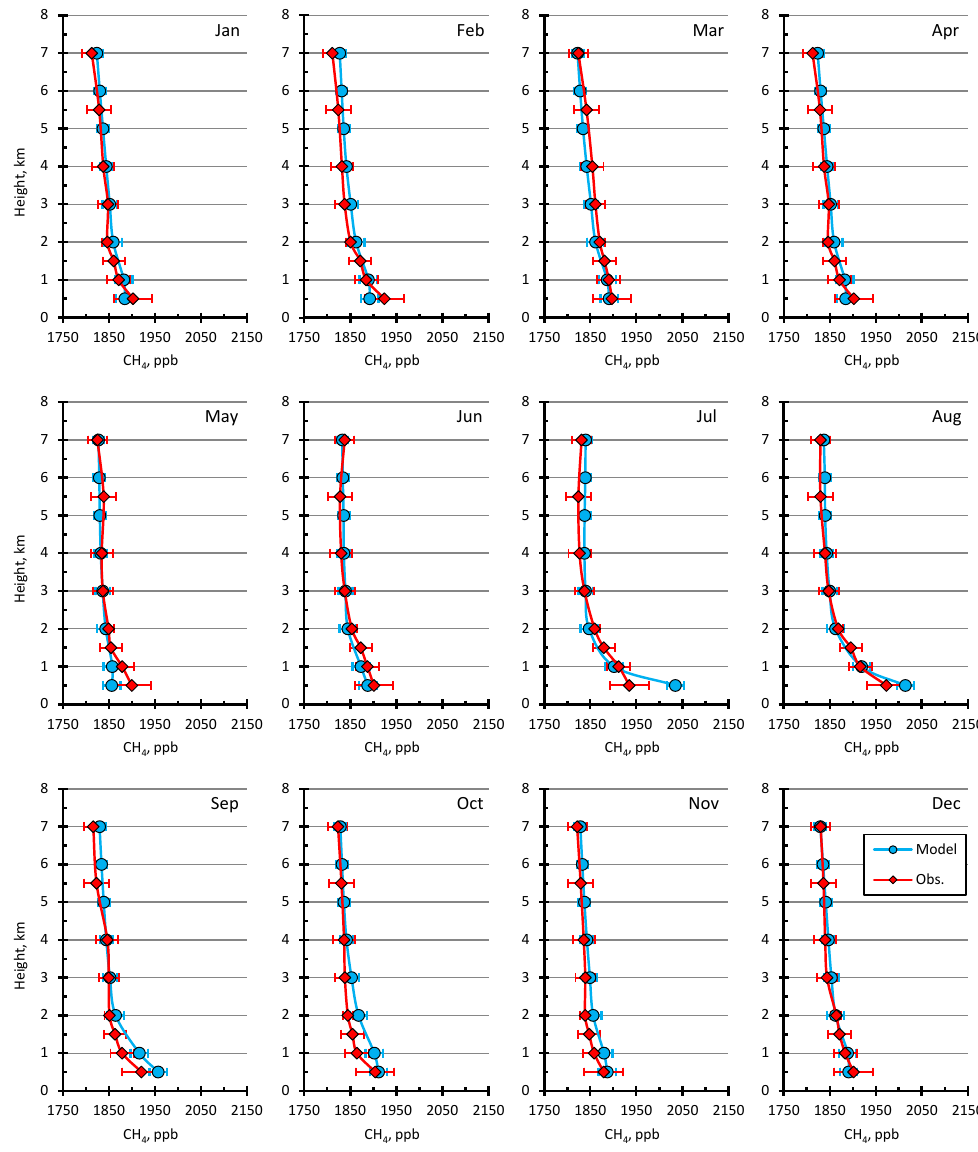
Fig. 8. Comparison of observed and modeled CH 4 concentrations averaged for the period 1993–2007 over Surgut, West Siberia. The vertical profiles were produced by averaging the modelled and observed concentrations taken on the same day and at the same time. Error bars show the standard